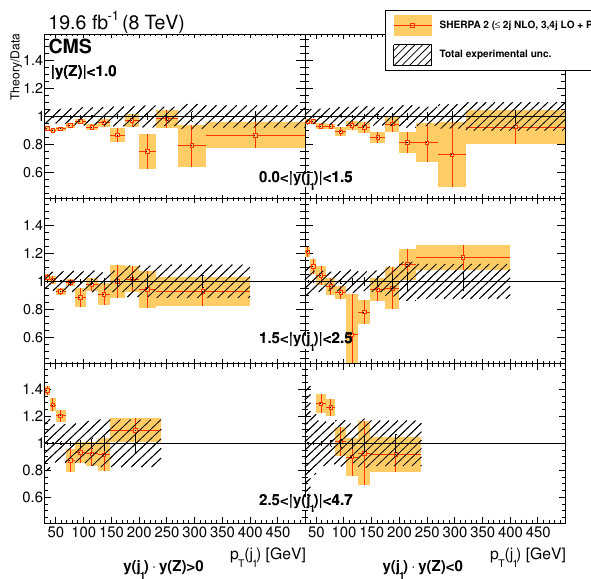
)d y (j )d y (Z) 1 1 ) y (Z) < 0. The total experimental 1